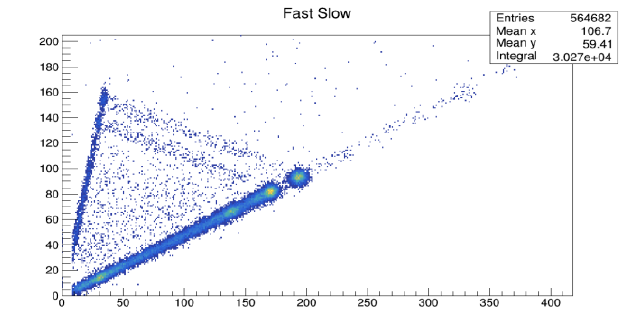
Fig. 4. Two-dimensional spectrum of fast (x-axis) and slow (y-axis) component of detector impulse in arbitrary units.